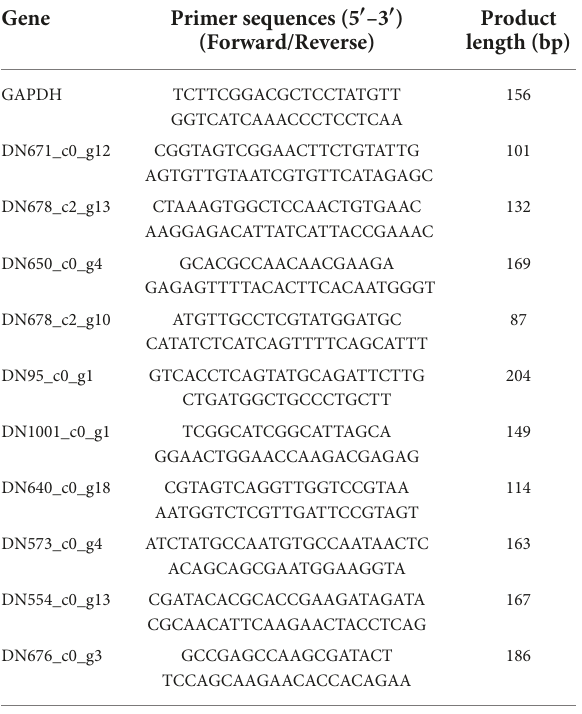
TABLE 1 Primer sequences in the present